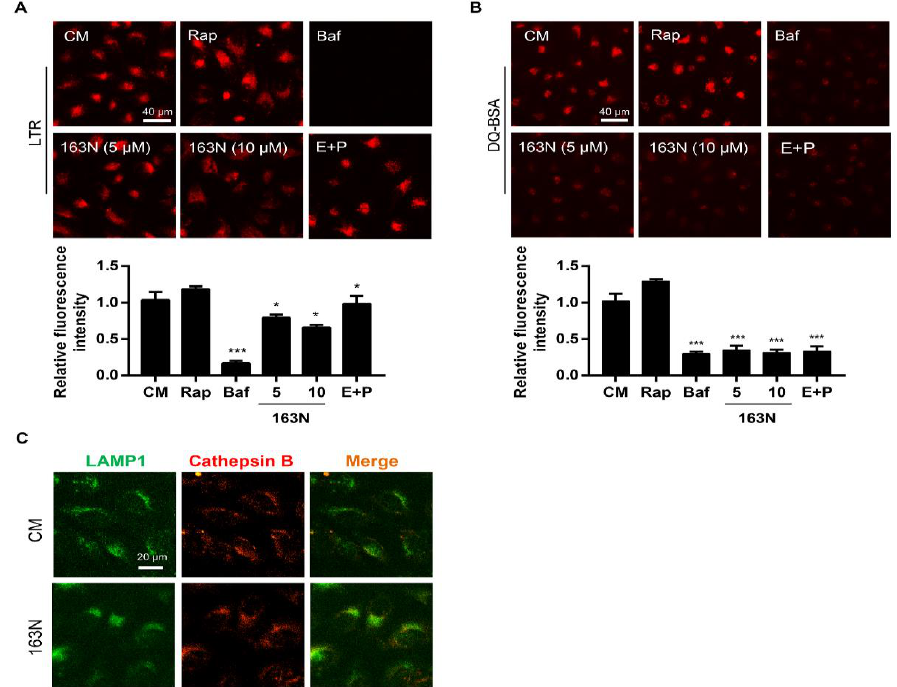
Figure 5. 163N causes lysosome dysfunction. ( A ) HeLa cells were treated with Rap (1 µ M), Baf (0.5 µ M), E64D (25 µ M) plus pepstatin A (50 µ M) or di ff erent concentrations of 163N (5 or 10 µ M) for 6 h,